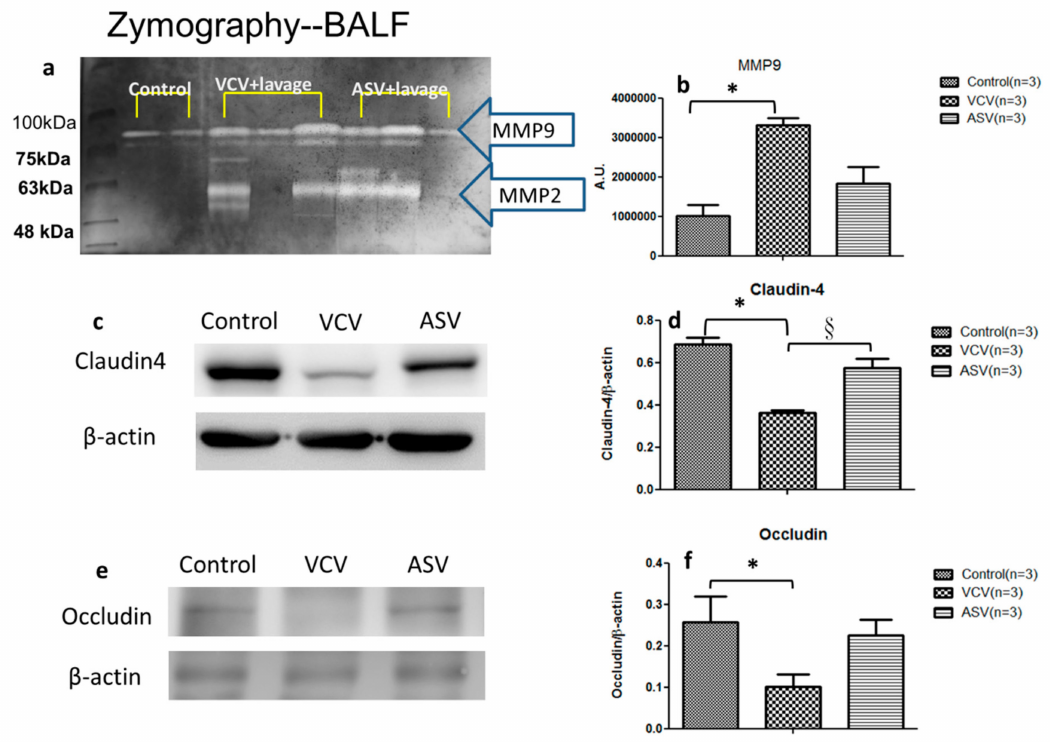
Figure 4. Gelatinase activity in BALF and expression of claudin-4 and occludin in the three experimental groups. ( a ) Bands corresponding to MMP-2 (63 kDa) and MMP-9 (80 kDa) are highlighted. ( b ) Quantitative data for MMP-9 are presented as mean ± SD. ( c ) Western blots of tissue samples show the di ff erence between groups in claudin-4 abundance. ( d ) Quantitative data for claudin-4 in each group were normalized to β -actin. ( e ) Western blots of tissue samples show di ff erence between groups in occludin abundance. ( f ) Quantitative data for occludin for each group were normalized using β -actin. * p < 0.05 compared with the control group; § p < 0.05 compared with the VCV